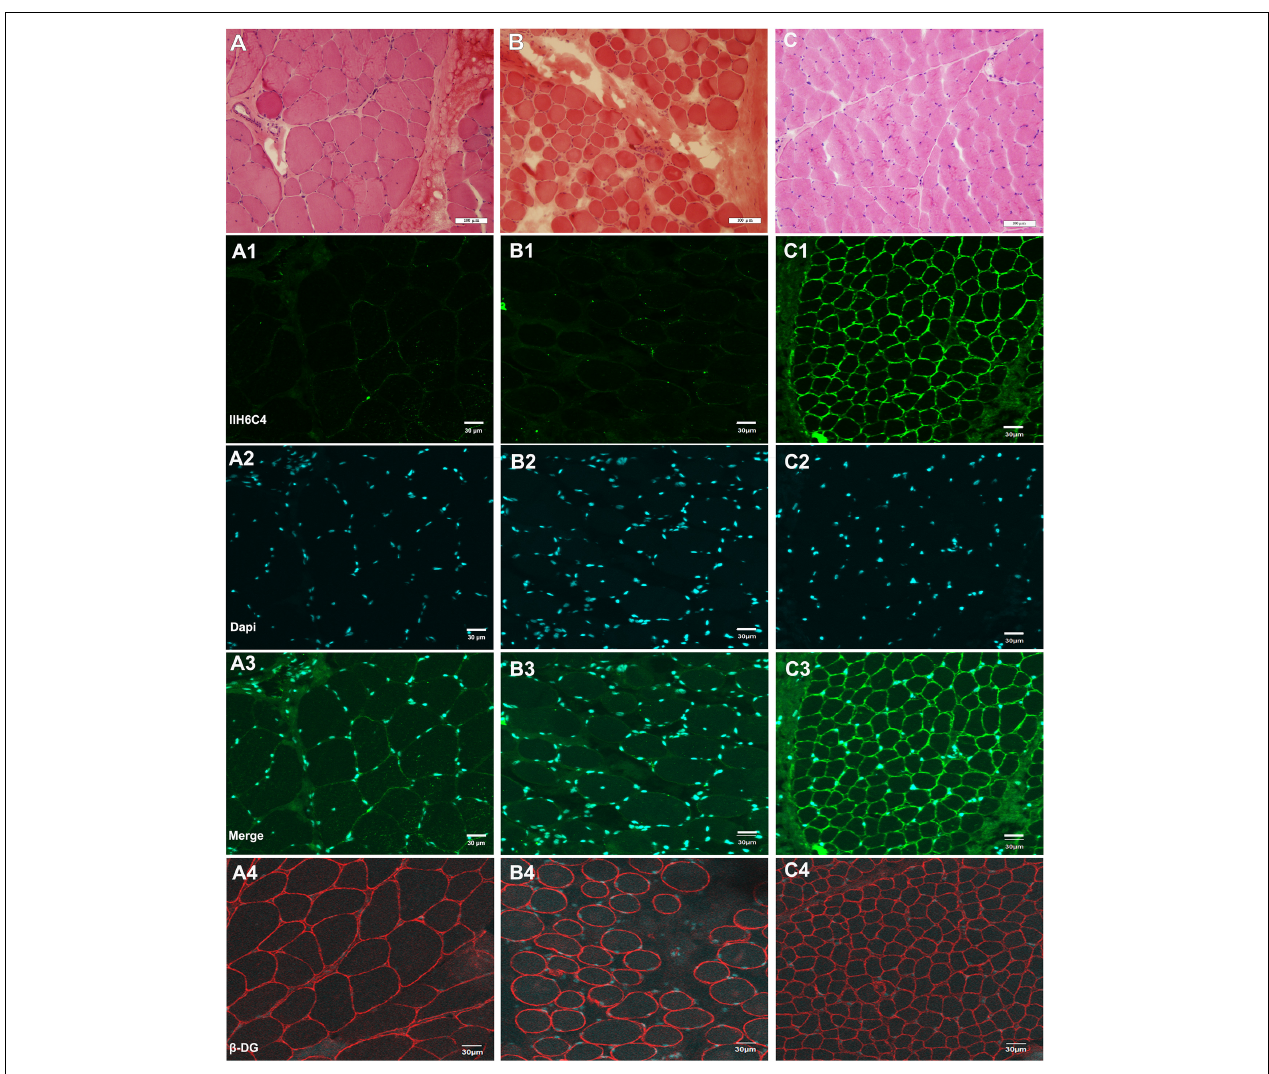
FIGURE 2 | Hematoxylin–eosin (HE) staining and immunofluorescence staining of IIH6C4 antibody of patients 6 and 7b (A,B) HE staining of patients 6, and 7b showed slightly increased variation of the muscle fiber diameter, and necrosis; (C) HE staining of the healthy control; (A1,B1,C1) Immunofluorescence staining of IIH6C4 antibody from patients 6, 7b, and the normal control, respectively; (A2,B2,C2) the staining of Dapi for cell nucleus of patients 6, 7b, and the normal control, respectively; (A3,B3,C3) the staining of merge, and the staining of patients 6 and 7b showed the expression of glycosylated α -DG in the cell membranes was much weaker than in the control; and (A4,B4,C4) the staining of β -DG antibody for patients 6, 7b, and the normal control, respectively.